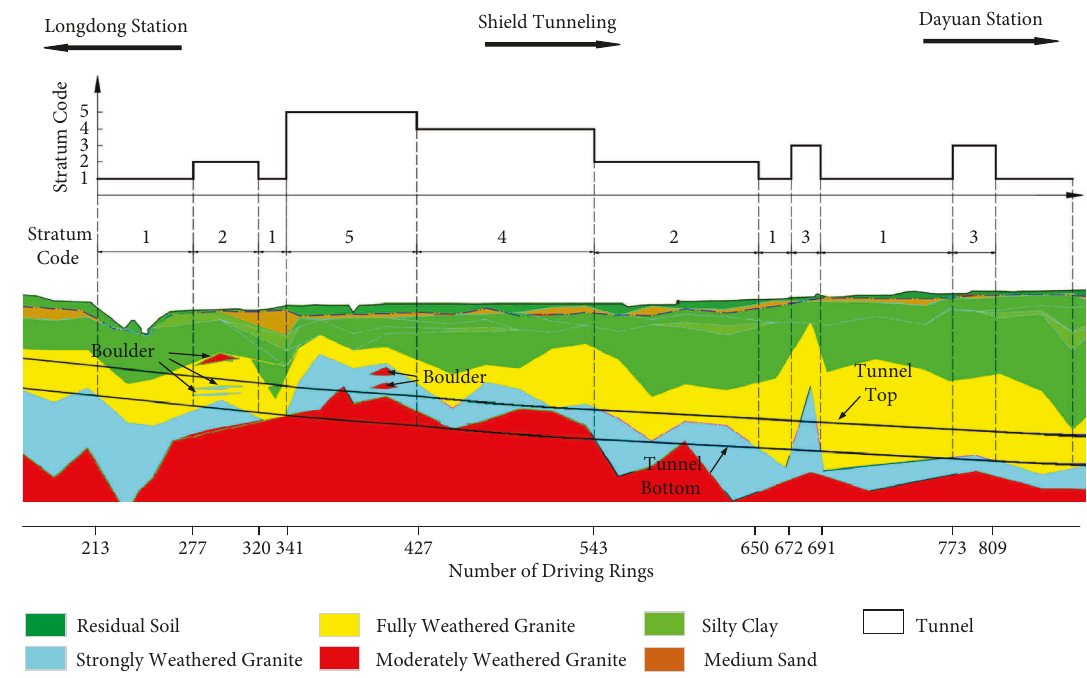
Figure 2: Stratum distribution and corresponding stratum code. Table 2: Rock and soil layer characteristics, construction conditions, and surrounding rock classification ∗ .